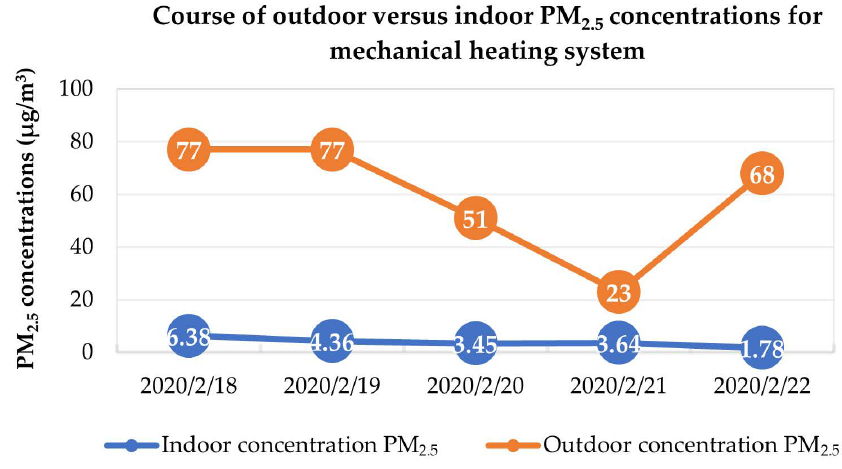
Figure 18. Courses of outdoor versus indoor PM 2.5 concentrations for MHS [33].